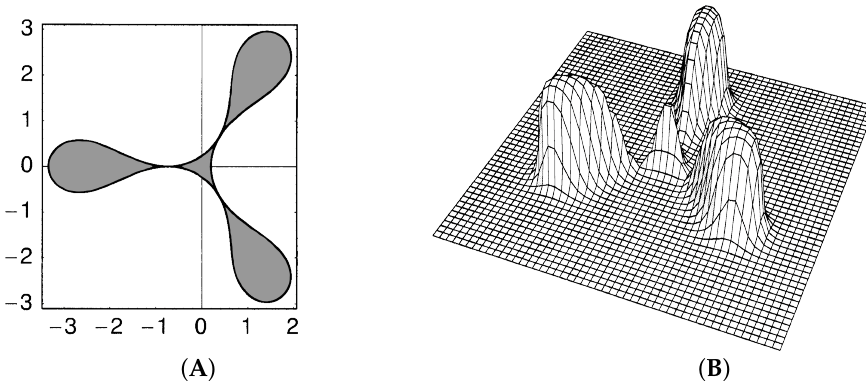
Figure 4. Illustration of analysis via method of thermo-vorticial spots (“blobs”). Left panel ( A ): A three-petal vorticity distribution is specified as q ( x ) = q 0 Θ ( x , y ) , where vorticity q 0 is constant and function Θ ( x , y ) is two-dimensional Heaviside step-function equal to one inside the shaded domain and zero outside. (Ref. [22] explains in detail the entire theory and methodology. This depicted three-petal thermo-vorticial structure takes this particular shape when one of the guiding parameters of the macro-configuration reaches its limit case.) Right Panel ( B ): For the vorticity distribution specified in Panel ( A ), the resulting temperature distribution τ ( x ) is obtained per Equation (28). The unit along the vertical axis is the characteristic magnitude of temperature excess τ 0 = q 0 α RL /2 πω . (The central τ peak is a consequence of the vorticity parametrization for the geophysical application in Ref. [22], which for a black hole accretion disk should be obviously nil.) Both Panels ( A,B ): For x and y axes, the unit is R = λ θ ( ω / Ω ) ; ω is the angular velocity of rotation of the vortex structure as a whole; Ω is the characteristic angular velocity of rotation of the accretion disk; and λ θ = ( αβ ) − 1/2 . In the expression for λ θ , the parameter α (characterizing the “rapidity” of increase in temperature with distance from the disk rotation axis) may be estimated as α = ( 8/ π 2 )( ∆ θ / R 2 ∗ ) . Here R ∗ is the characteristic radius of the accretion disk (obviously not equal to R ) is presumed to be greater than size of the macro-structure, and ∆ θ may be estimated as the temperature difference across the disk (from the periphery to the center). In the expression for λ θ , the parameter β = − ρ − 1 ( ∂ρ / ∂θ ) is the coefficient of thermal expansion, which (for the model whose equation of state is approximated by the equation for an ideal gas) may be written as β (cid:39) θ − 1 , where θ is the averaged temperature of the accretion disk.